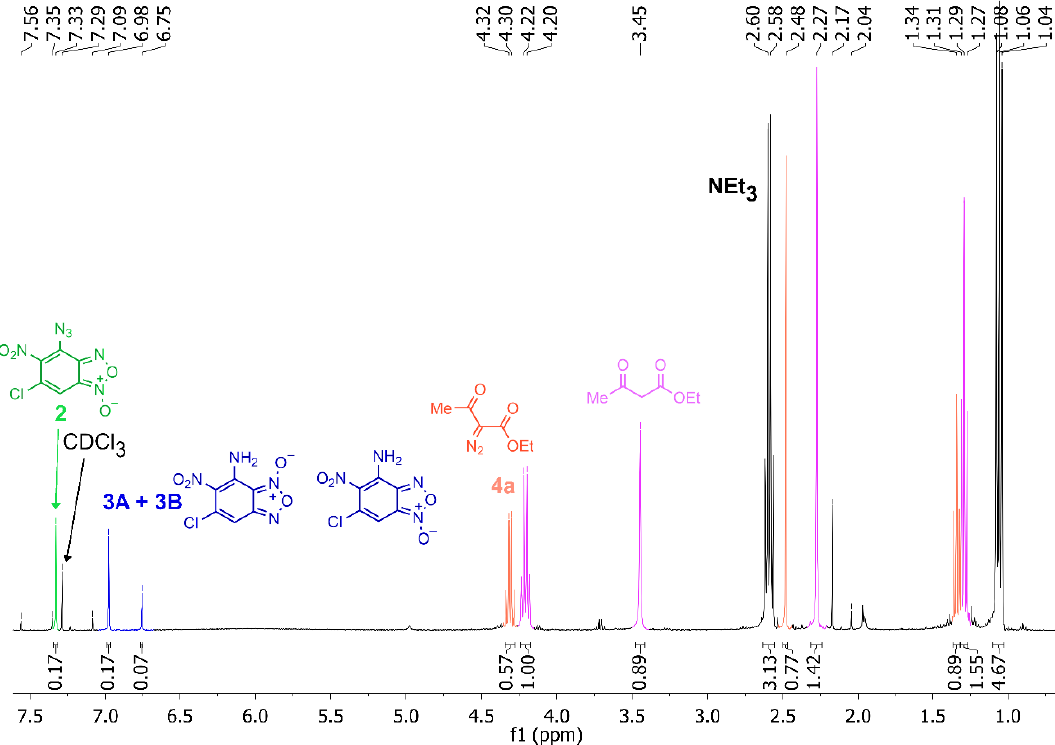
Figure 2. EI mass spectrum of peak of hydrated molecular ion of 4a [M+H 2 O] + • and the range of the fragmentation peaks obtained from the addition of water to the compound 4a .